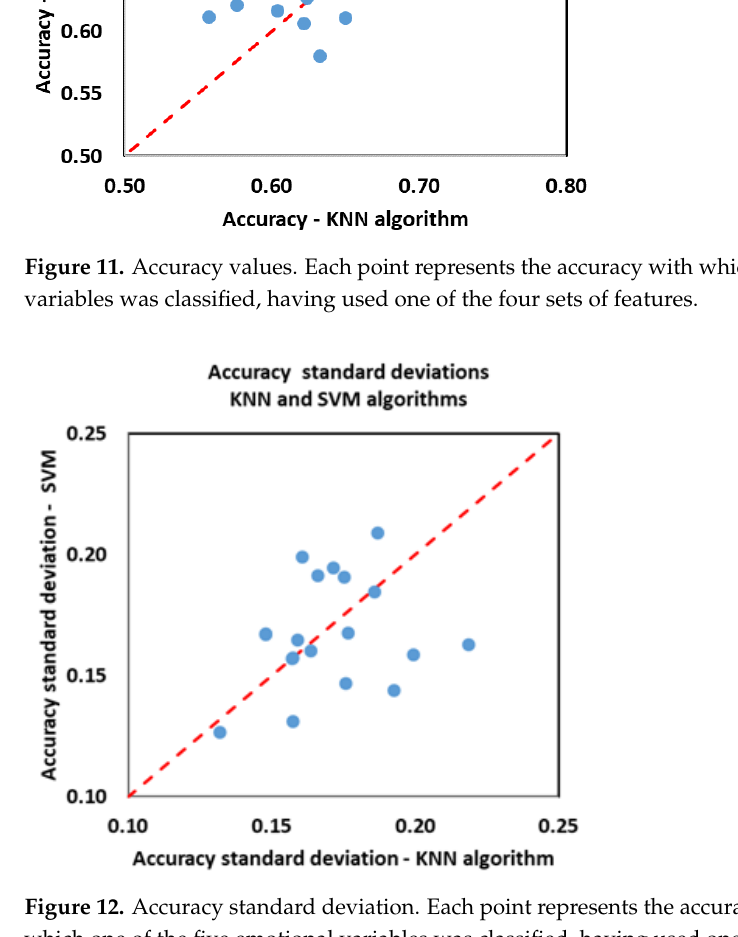
Figure 12. Accuracy standard deviation. Each point represents the accuracy standard deviation with which one of the five emotional variables was classified, having used one of the four sets of features.